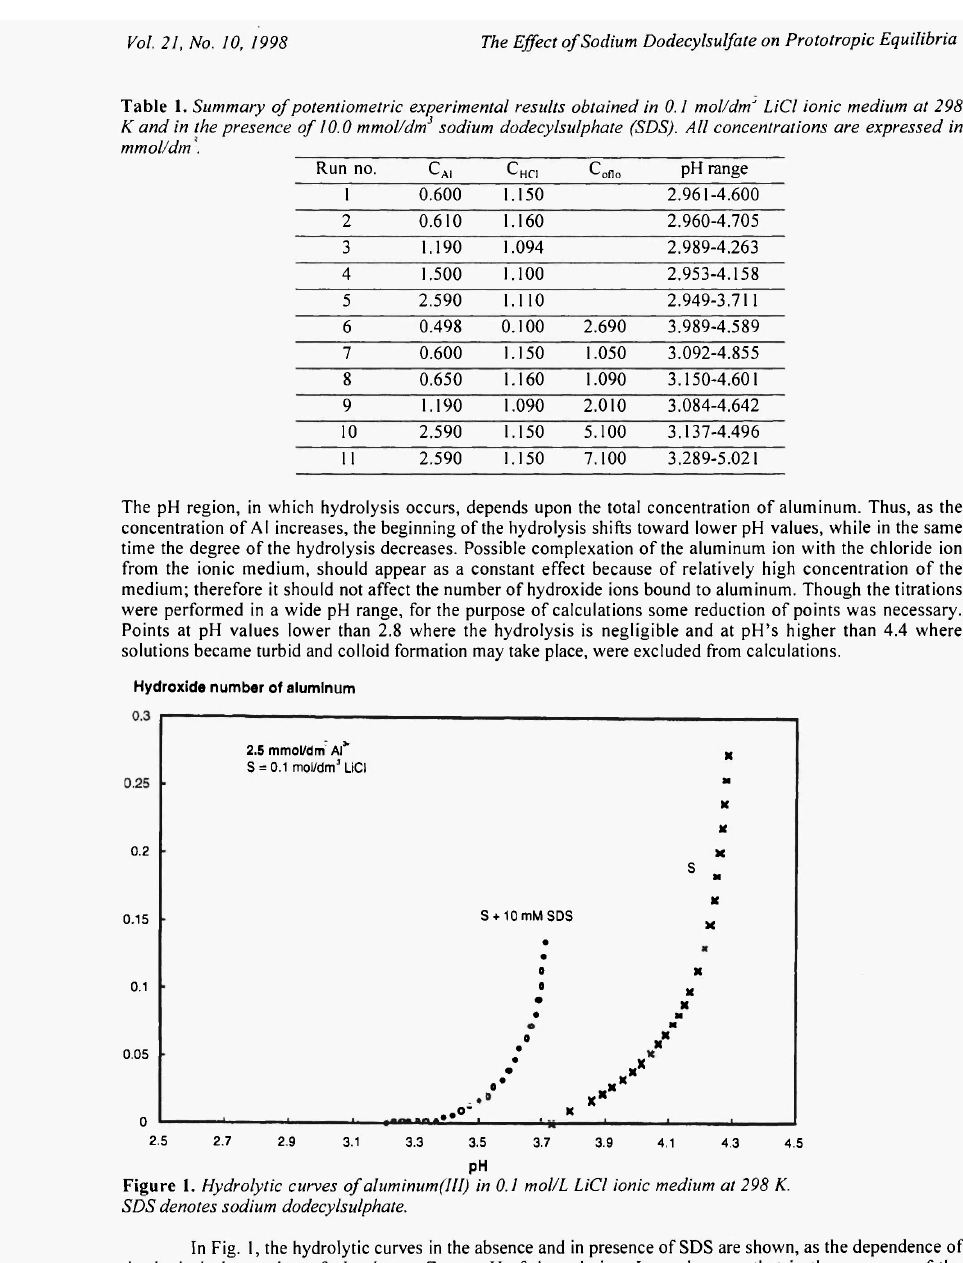
Figure 1. Hydrolytic curves of aluminum(IU) in 0.1 mol/L LiCl ionic medium at 298 K. SDS denotes sodium